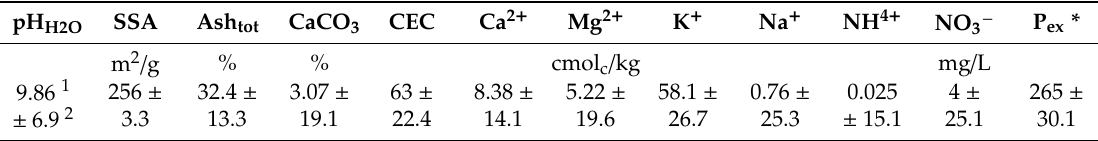
Table 3. Properties of wheat straw biochar.